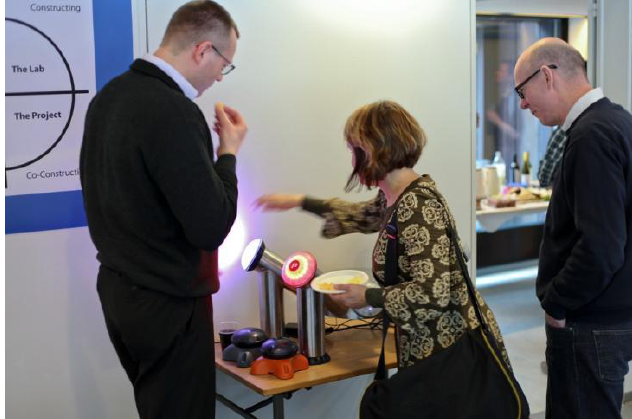
Fig. 6. Presenting research results as showroom demonstrator to the